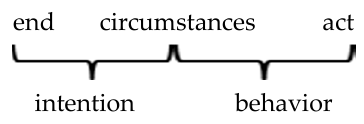
Figure 1. The sources of morality (expanded).